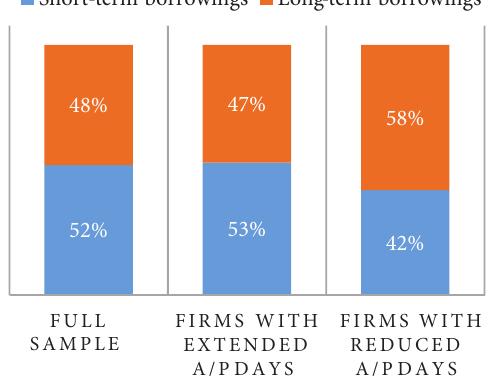
Figure 3. Short-term borrowings and Profitability under the influence of A/P days